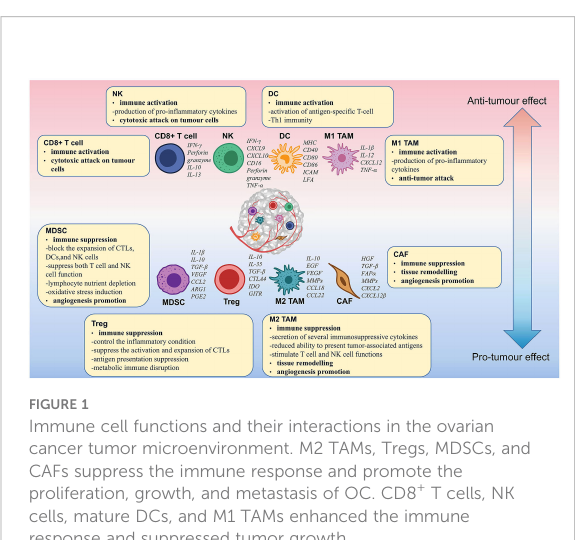
FIGURE 1 Immune cell functions and their interactions in the ovarian cancer tumor microenvironment. M2 TAMs, Tregs, MDSCs, and CAFs suppress the immune response and promote the proliferation, growth, and metastasis of OC. CD8 + T cells, NK cells, mature DCs, and M1 TAMs enhanced the immune response and suppressed tumor